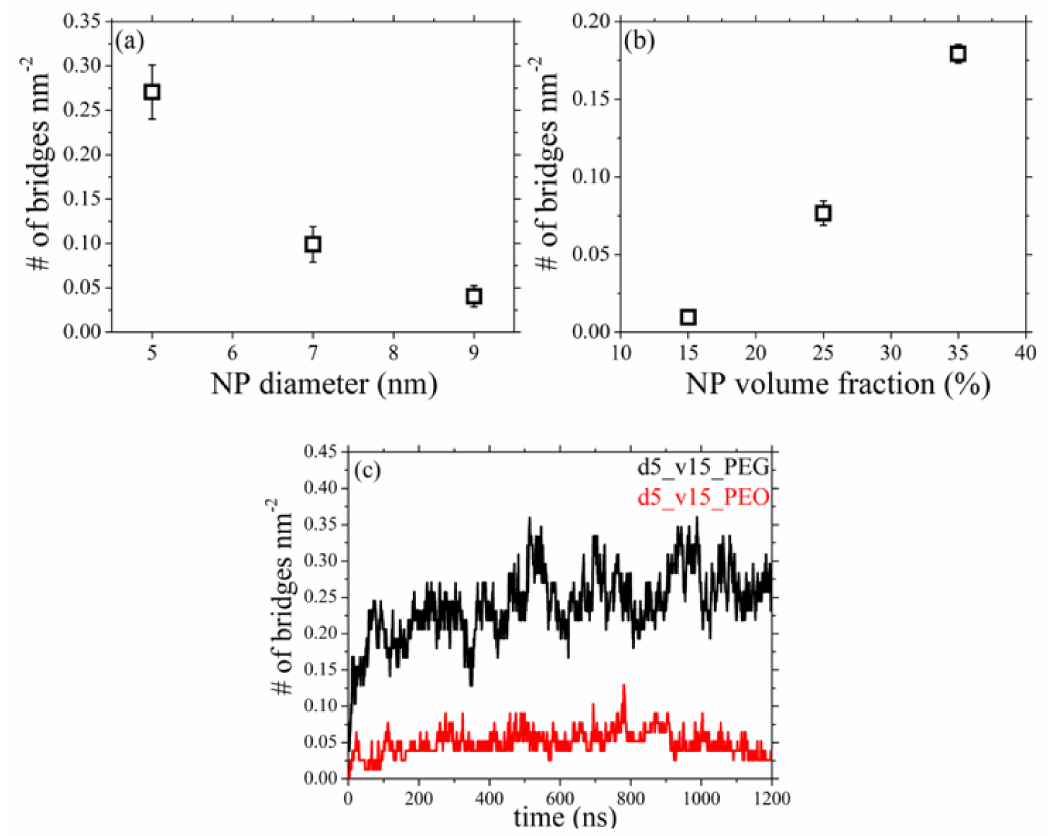
Figure 7. Number of polymer bridges per silica nm 2 from the present npT MD simulations ( T = 413 K and p = 1 atm) as a function of: ( a ) nanoparticle diameter (systems 2–4), and ( b ) nanoparticle volume fraction (systems 5–7). ( c ) Time evolution of the number of bridges formed per silica nm 2 in the d5_v15_PEG and d5_v15_PEO